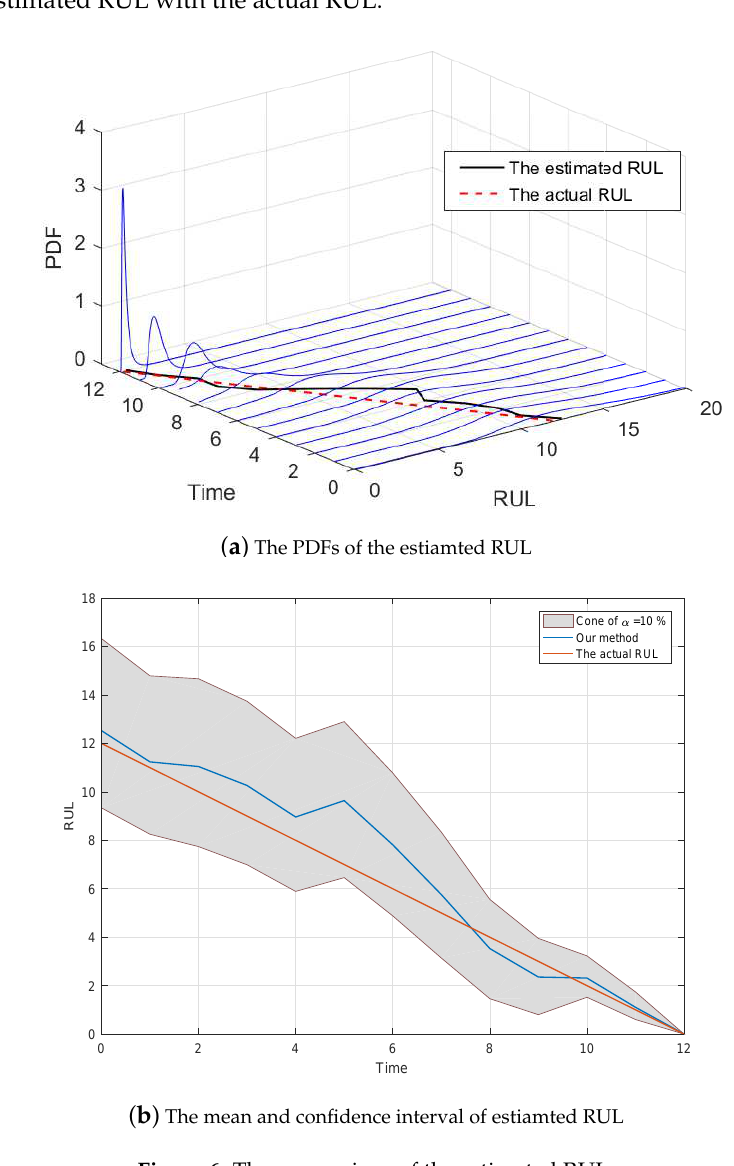
Figure 6. The comparison of the estimated